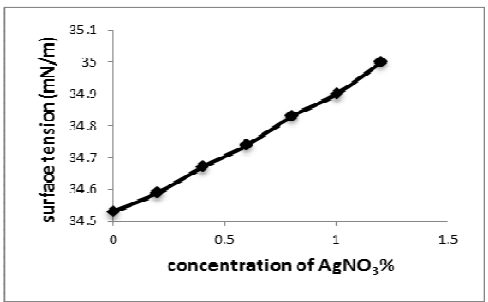
Fig. 6. Effect the (AgNO of (Nylon